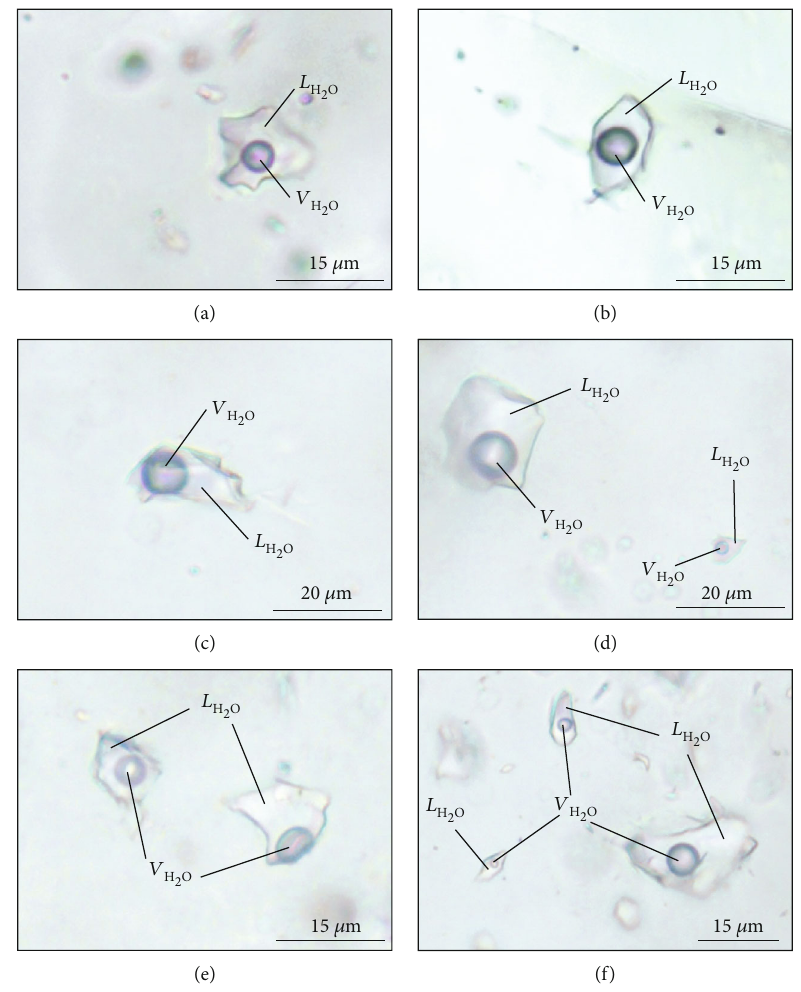
Figure 3: Gas-liquid two-phase fl uid